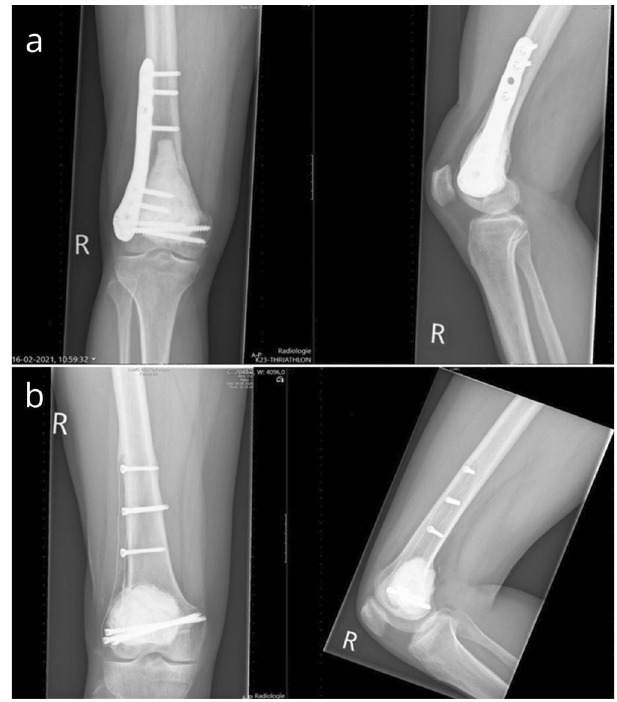
Figure 1. Giant cell tumor in the right distal femur treated with bone cement during curettage using a metal plate ( a ) and a carbon-fiber plate ( b